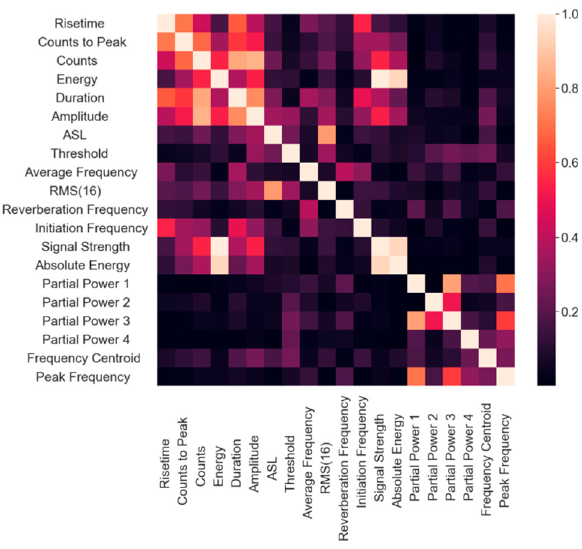
ffi cient correlation Figure 5. Pearson coefficient correlation matrix. Figure 5. Pearson coe